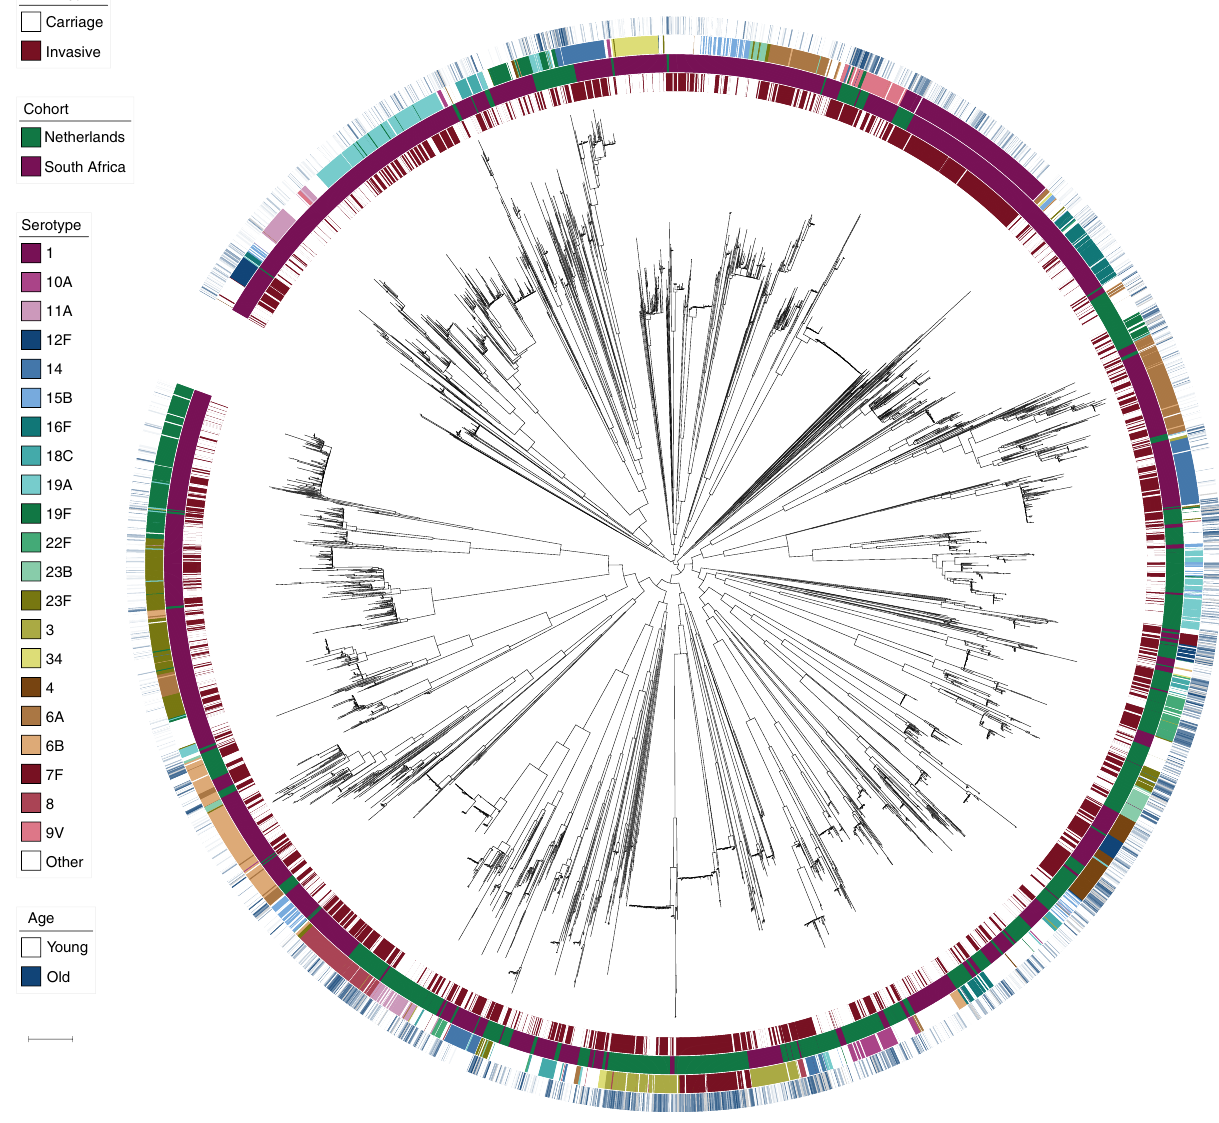
Fig. 3 Phylogenetic tree of all samples included in the pathogen genome-wide association study. Rings show metadata about samples, from inside to outside: phenotype (carriage or invasive); cohort (Netherlands or South Africa); common serotypes; patient age on a continuous scale from younger (white) to older (blue). Scale bar: 0.01 substitutions per site. An interactive version is available at https://microreact.org/project/Spn_GWAS/9eb0bd5d (project link